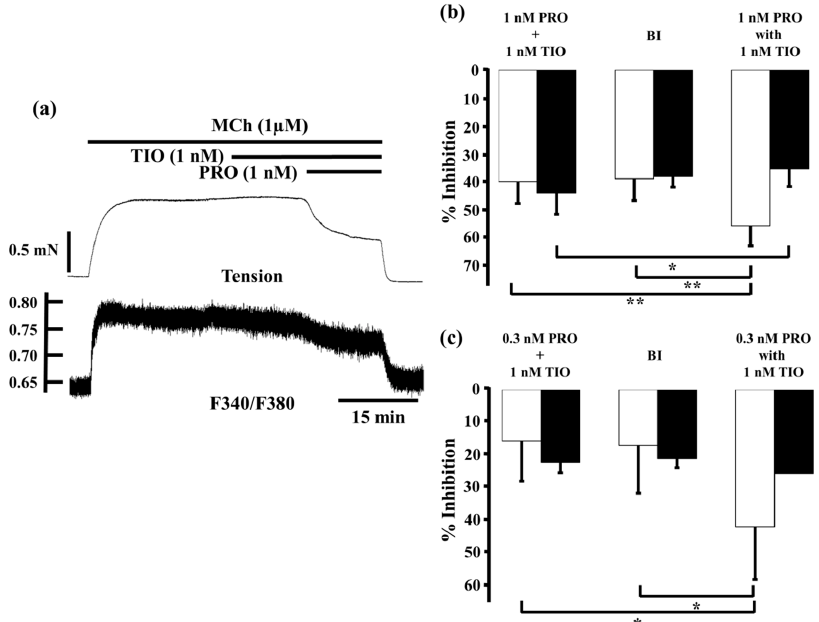
Figure 6. Effects of combination of procaterol and tiotropium on tension and intracellular Ca 2+ concentration induced by muscarinic activation. ( a ) A typical sample record of tension ( upper side ) and F340/F380 ( lower side ) showing the inhibitory effect of procaterol (1 nM) in the presence of tiotropium (1 nM) against 1 μ M MCh-induced contraction; ( b , c ) Percent inhibition of tension (white columns) and F340/F380 (black columns) in 1 μ M MCh-precontracted tissue incubated with 1 nM procaterol ( b , n = 5) and 0.3 nM procaterol ( c , n = 4) in the presence of tiotropium (1 nM). Left , sum of percent inhibition of tension and F340/F380 by the two agents; Center , expected percent inhibition of tension and F340/F380 calculated by the Bliss independence theory; Right , percent inhibition of tension and F340/F380 with the two agents in combination. PRO, procaterol; TIO, tiotropium; MCh, methacholine; BI, Bliss independence. ** p < 0.01; * p < 0.05.